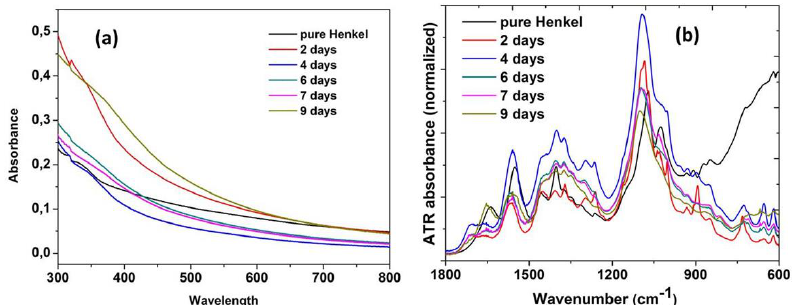
Figure 5. Spectroscopic characterization of coolant Henkel Multan 61-3 DF ( a ) absorption; and ( b ) ATR spectrum, for a 9 day ageing